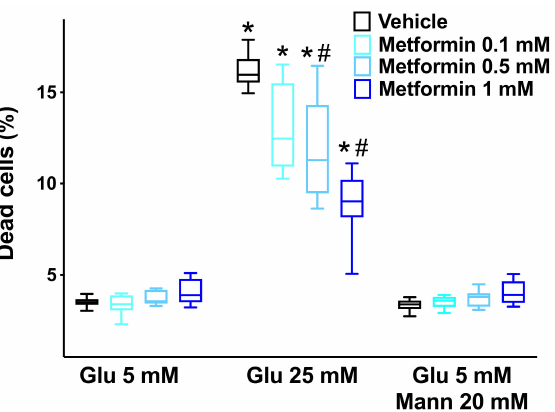
Figure 6. Metformin attenuates high-glucose-induced cell death. By using a luminogenic Caspase- Glo ® 3/7 assay, we evaluated the effects of increasing concentrations of metformin on the apoptosis of human brain microvascular endothelial cells induced by high-glucose (Glu: glucose; Mann: mannitol). The experiments were performed in triplicate. Box plots indicate upper/lower quartiles, the line in the middle of each box is the mean, and the whiskers represent the 5th–95th percentile range of values; *: p < 0.05 vs. Glu 5 mM; #: p < 0.05 vs.